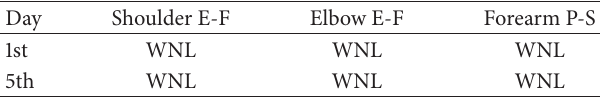
Table 2: SEFRE clinical trial result of 3 subjects: PROM.